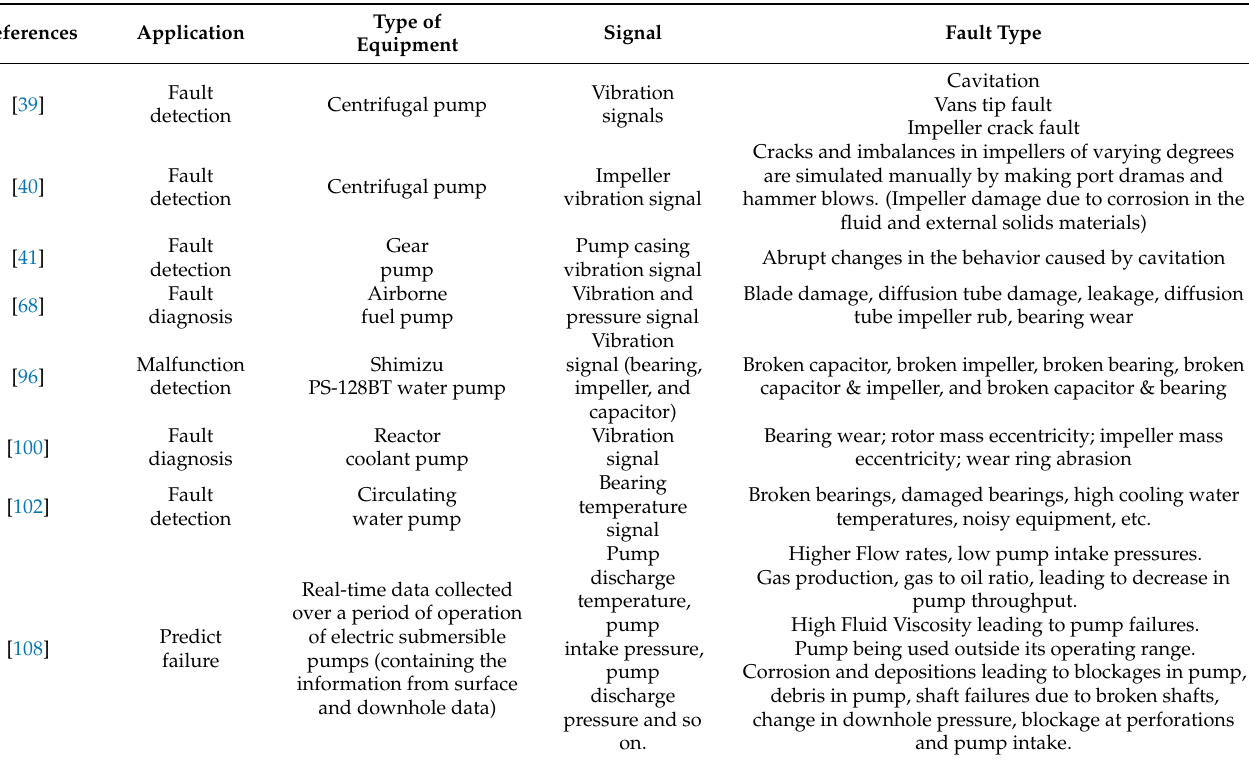
Table 11. Pump condition monitoring using artificial neural